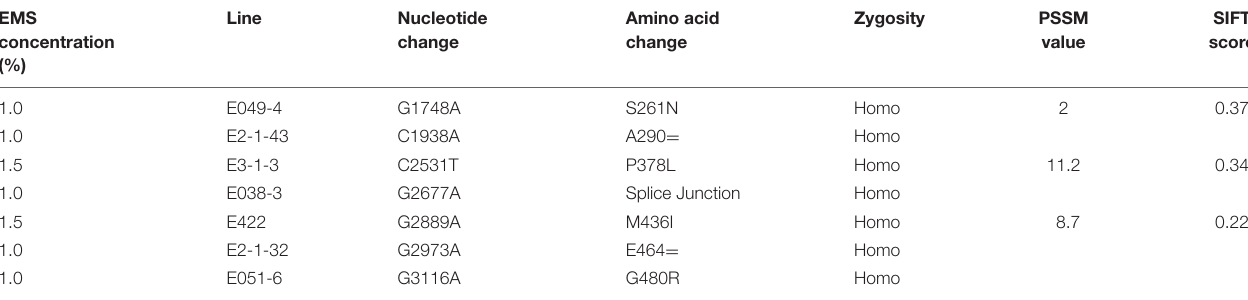
TABLE 1 | Missense, synonymous, and splice mutations identified in gene TaAGP.L-B1 .